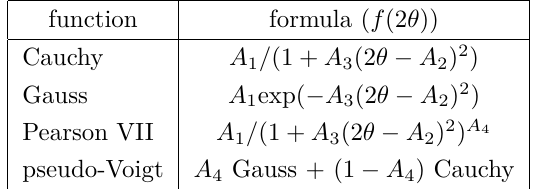
Table 1. Implemented fitting functions with following parameters: intensity at maximum A position of the maximum A and the shape parameter A